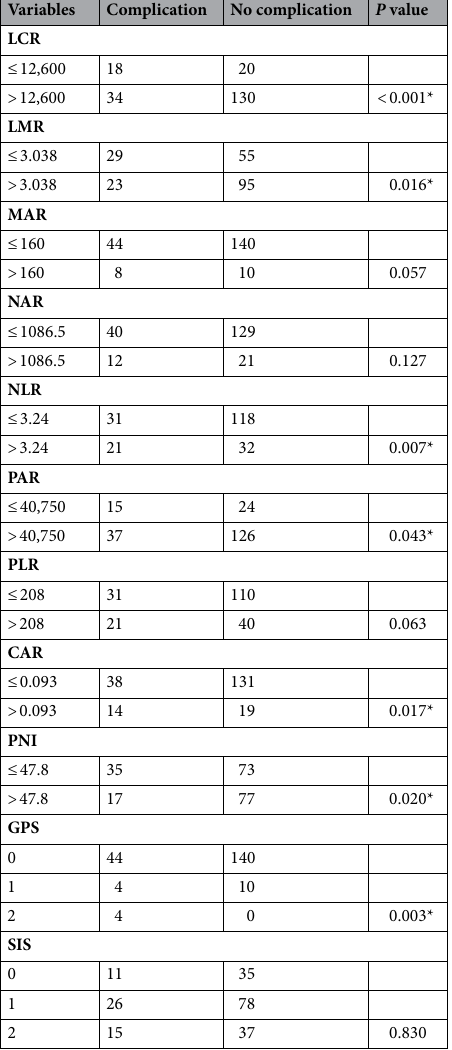
patients underwent neoadjuvant chemoradiotherapy (nCRT) and six patients underwent neoadjuvant chemo- therapy (NAC) in the present study. In our dataset, there was no significant difference in LCR between patients